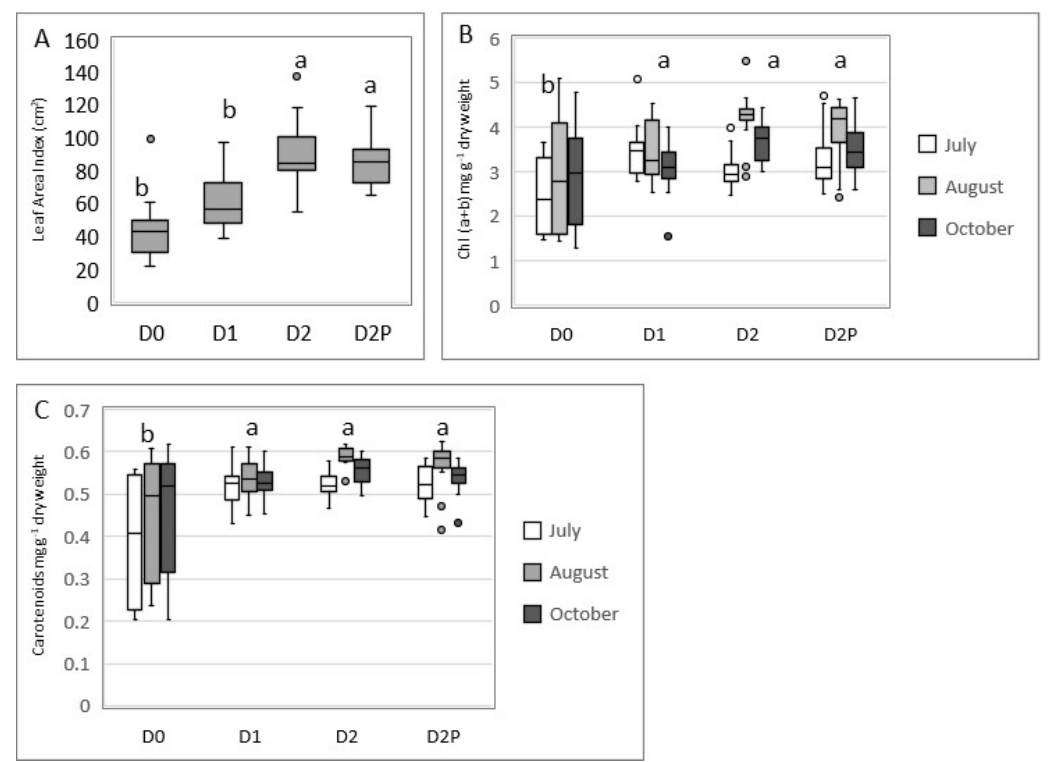
Figure 5. Leaf parameters during the growing season in 2020. ( A ) Average leaf surface area expressed in cm 2 . ( B , C ) Average leaf chlorophyll and carotenoids concentrations (expressed in mg g − 1 dry weight). Lowercase letters indicate statistical groupings ( p < 0.05). The horizontal line inside each box-whisker represents the median, vertical small rectangles represent interquartile ranges, and circles are data-outliers.